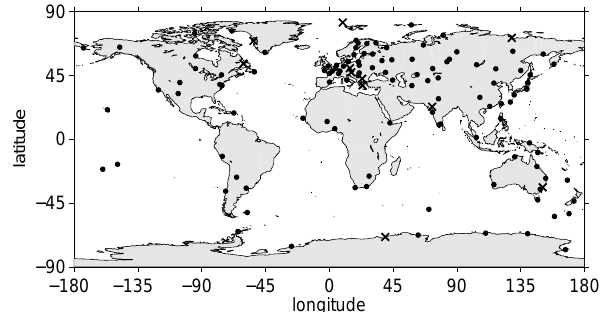
Fig. 1. Ionosonde stations with observations of at least 22 years from the databank of Damboldt and Suessmann (2012a). Dots in- dicate stations with fo F2 and M(3000)F2 data, and crosses indicate stations with fo F2 data